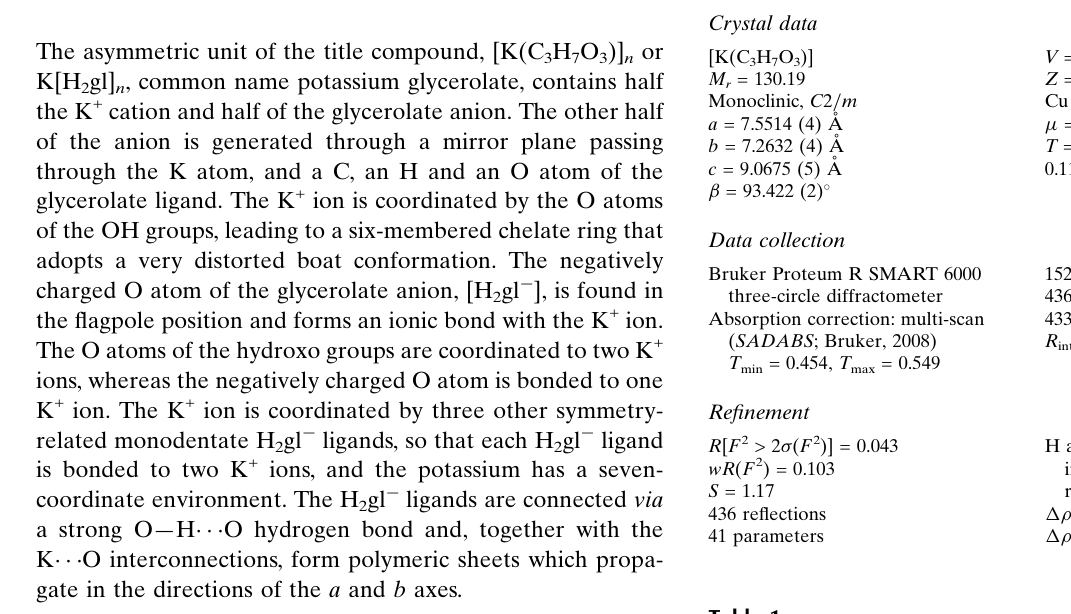
Experimental Crystal data